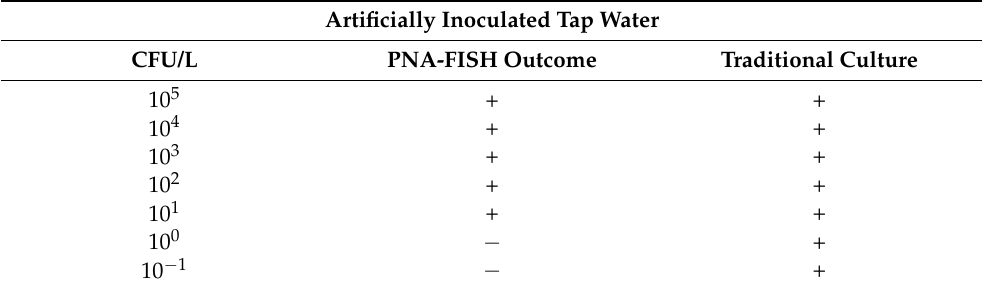
Table 3. Artificially inoculated tap water results with PNA ‐ FISH (both directly in the membrane and in the eluted cells) and with traditional culture.